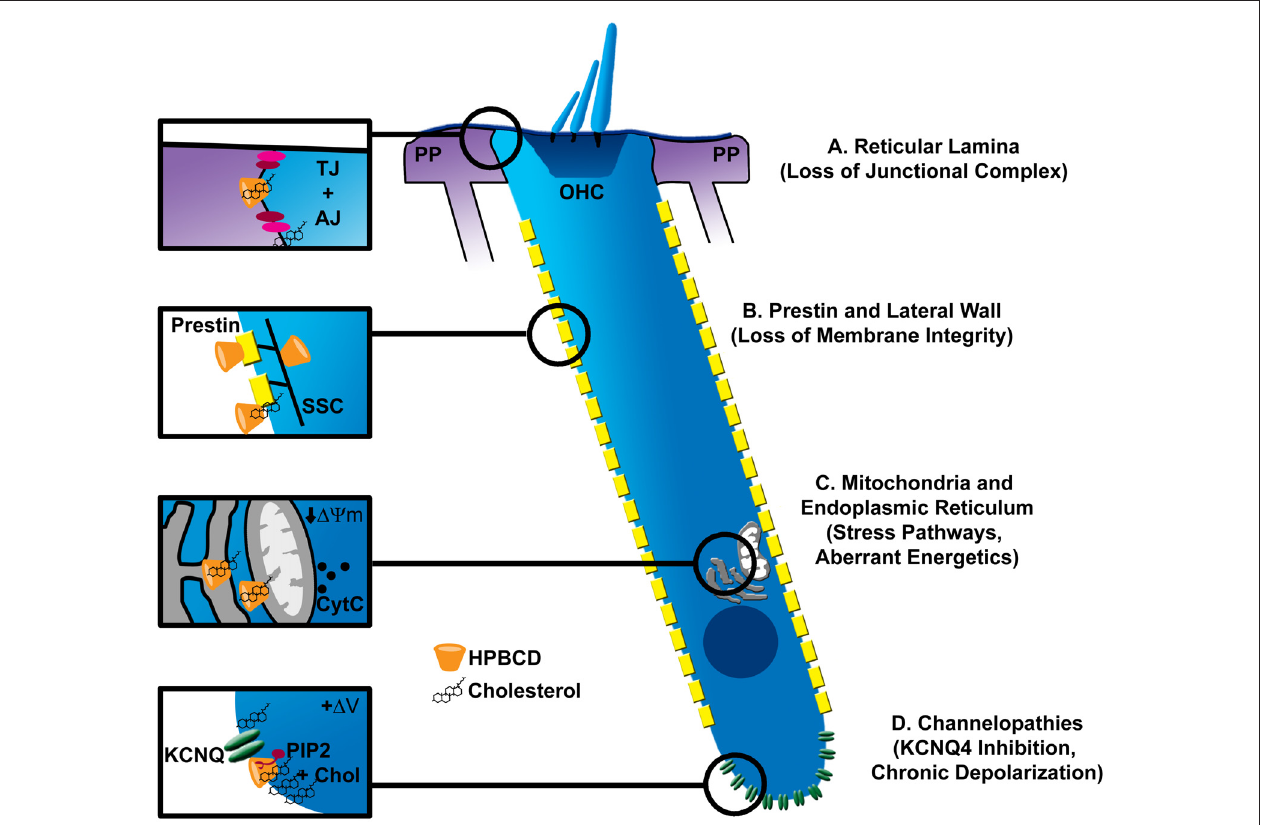
FIGURE 2 | Possible sites of pathologic interaction of cyclodextrins with outer hair cells (OHCs). (A) Cyclodextrins disrupt cell-cell junctional complexes (TJ, tight junctions; AJ, adherens junctions), which could breach the reticular lamina of the organ of Corti, allowing the high-potassium endolymph to bathe OHCs, leading to their excitotoxic death by prolonged depolarization. (B) The trilaminate structure of the OHC lateral wall is composed of prestin-rich plasma membrane connected to subsurface cisterane (SSC) by a cortical lattice. Removal of membrane cholesterol by cyclodextrins alters OHC membrane fluidity, stiffness and prestin-based motility. Since cholesterol level in the lateral wall appears low, it is unclear if cyclodextrin modifies these properties by interacting with plasma membrane lipids, membrane resident proteins like prestin, or the SSC. Nonetheless, loss of membrane integrity may be one mechanism of cyclodextrin-induced ototoxicity. (C) Since cyclodextrins can be endocytosed, they can potentially affect the membranes of intracellular organelles. Mitochondria and the endoplasmic reticulum (ER) represent common targets of other ototoxins. Specifically, cyclodextrins have been shown to reduce the mitochondrial membrane potential ( ∆Ψ m) and cause cytochrome release (CytC). Altered function in either organelle could contribute to OHC demise. (D) Cholesterol is non-uniformly distributed in the OHC plasma membrane, being enriched at the apical and basal poles of the cell. High concentrations at the base overlap with the expression of KCNQ4-type potassium channels, which also require the phospholipid PIP2 for proper function. Disruption of a channel-PIP2-cholesterol complex by cyclodextrin could cause loss of KCNQ4 current, chronic depolarization and ultimately excitotoxic